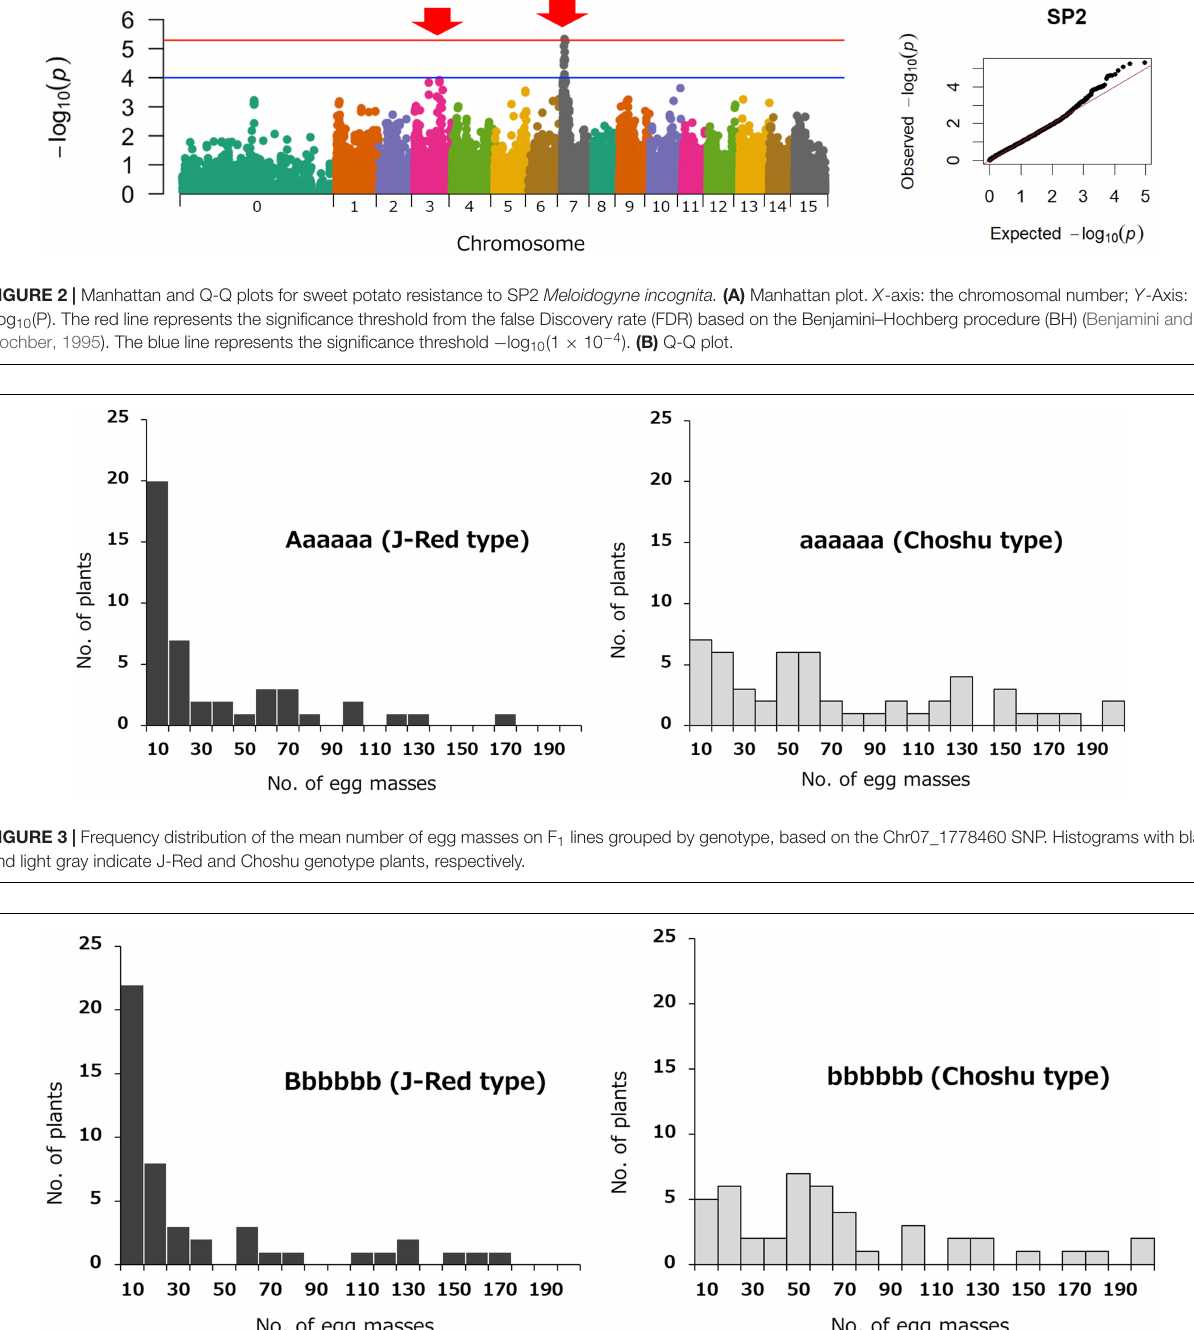
showing a significant difference at the 0.1% level between the two genotypes ( P = 3.763E-05, Wilcoxon rank sum test; Supplementary Figure 1 ). Subsequently, the SNP marker for J-Red and Choshu showed the genotypes of Bbbbbb